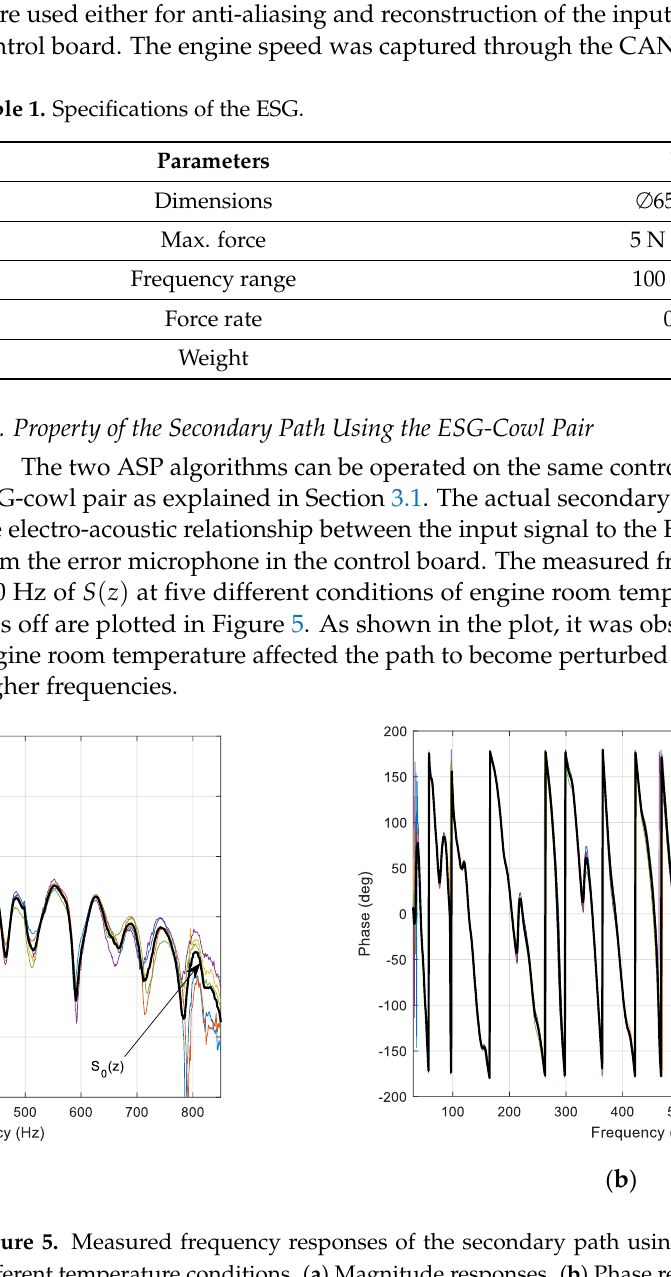
Figure 6. Impulse response of the nominal secondary path